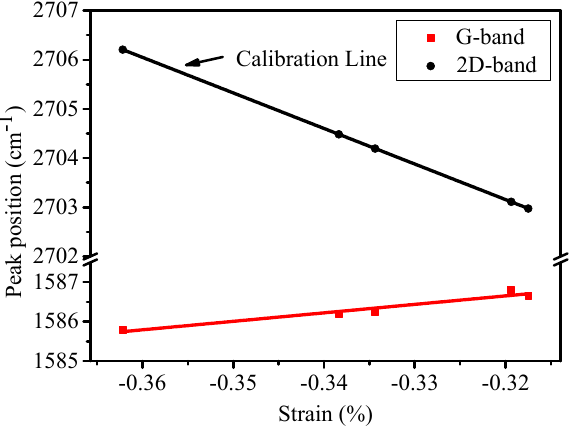
Figure 5. Peak positions of G-band and 2D-band as a function of strain.